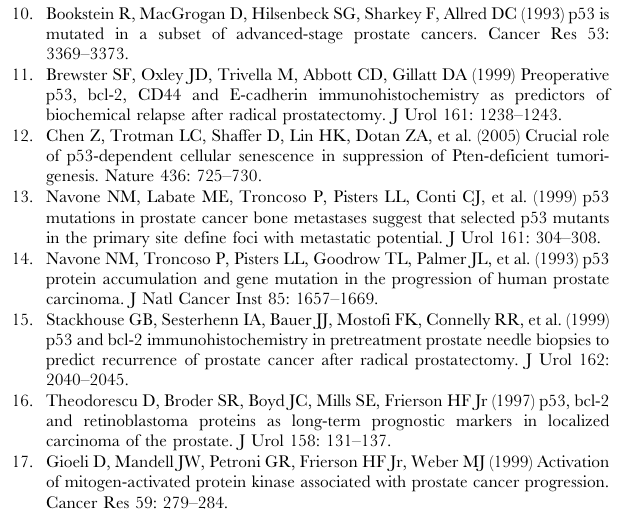
Figure S1 BRAF* transgene expression is documented by transgene-specific RT-PCR with two independent prostate tumors of bi-transgenic iBRAF* mice on doxycycline. Figure S2 Both ductal and spindled components of iBRAF* prostate tumors were negative for neuroendocrine markers (chromogranin and synaptophysin) by IHC. For controls, pancreatic tissues were used. Figure S3 Grafts from recombinant study showed a profile of lineage marker that is identical to that of the de novo iBRAF* PCA tumors. Figure S4 iBRAF* tumors regress after castration. A. Repre- sentative consecutive multi-slice MRI images (1.2 mm thickness) of pelvis of iBRAF* mouse # 46 at baseline imaging (pre-castration) showing heterogeneous signal intensity characteristic of tumor (blue highlight). B. Changes in prostate tumor volumes over time after castration (n= 5) were calculated based on ROI on serial